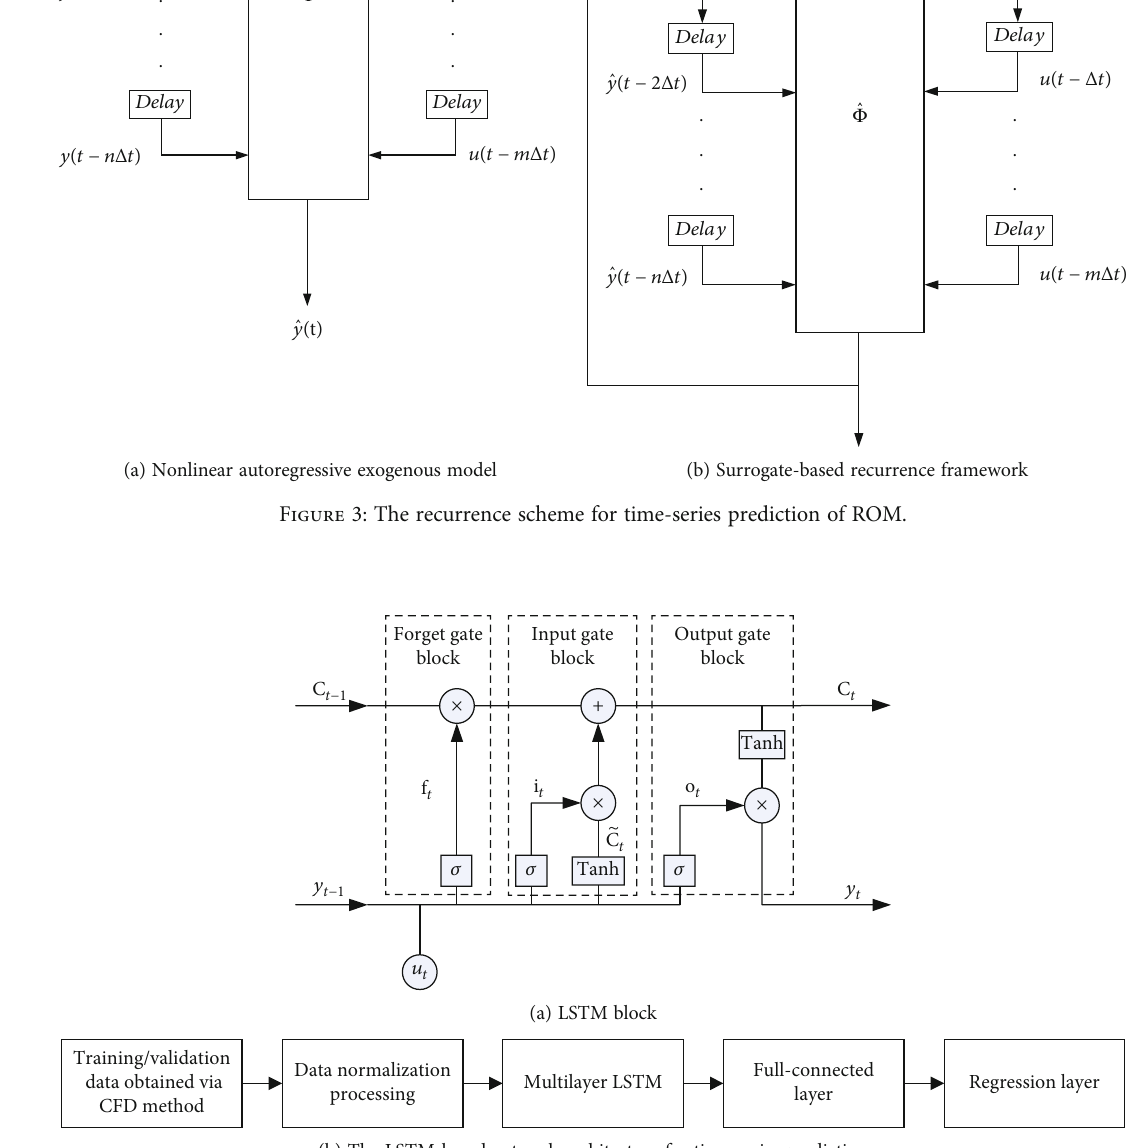
Figure 4: The LSTM scheme for time-series prediction of